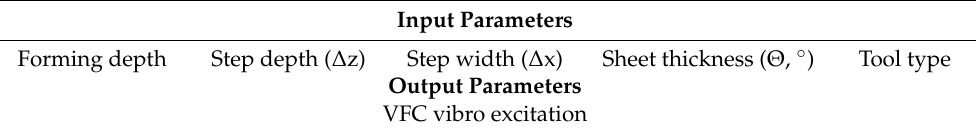
Table 5. Training parameters.